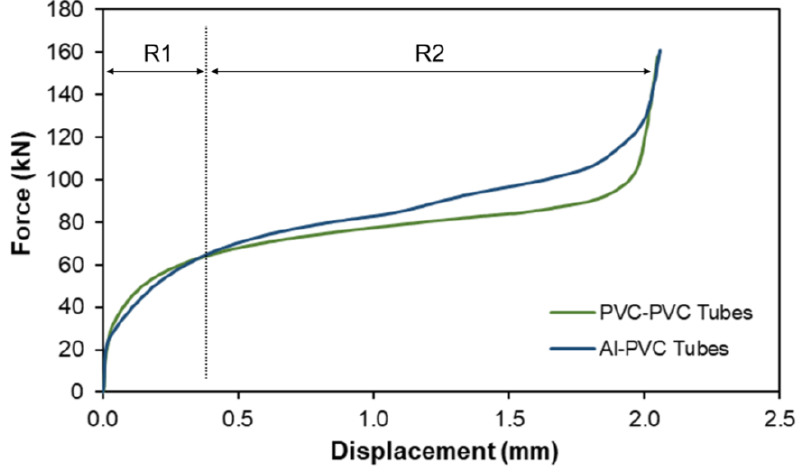
Figure 9. Experimental force – displacement evolutions for two PVC tubes as well as an upper tube of PVC and a lower tube of aluminum.